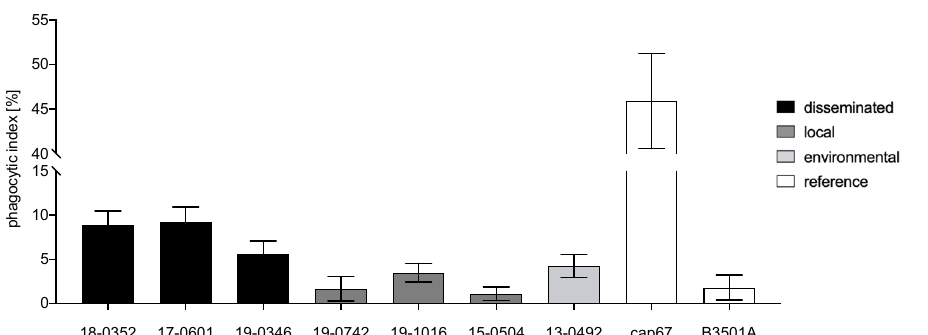
Figure 5. Phagocytic index representing the percentage of A. castellanii with intracellular C. neoformans var. neoformans cells after incubation in PYG medium at 29 °C for two hours. Clinical isolates from disseminated infections (black) are better phagocytosed than isolates from localized infections (grey) and the environment (light grey). To define the range of this assay, a C. neoformans wild-type reference strain (B3501A) and an acapsular strain (cap67) were included (white). The standard deviations of three independent experiments with eight technical replicates each are shown.